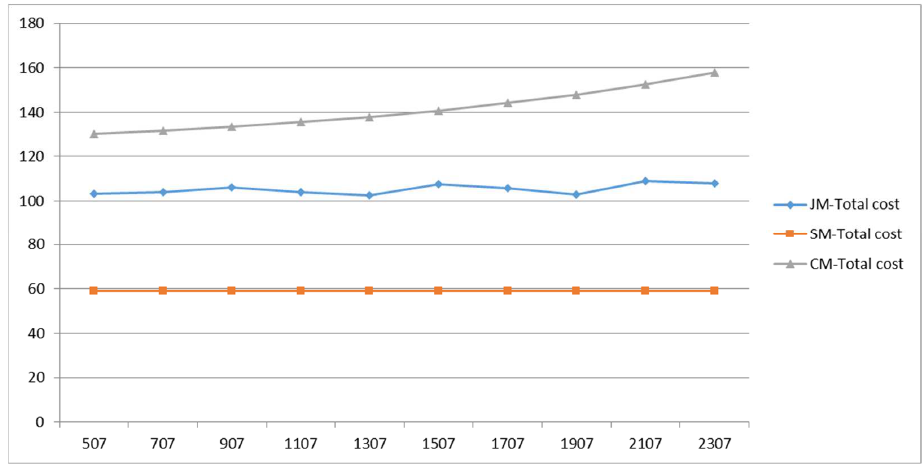
Figure 12. Total cost variations with parameter q .